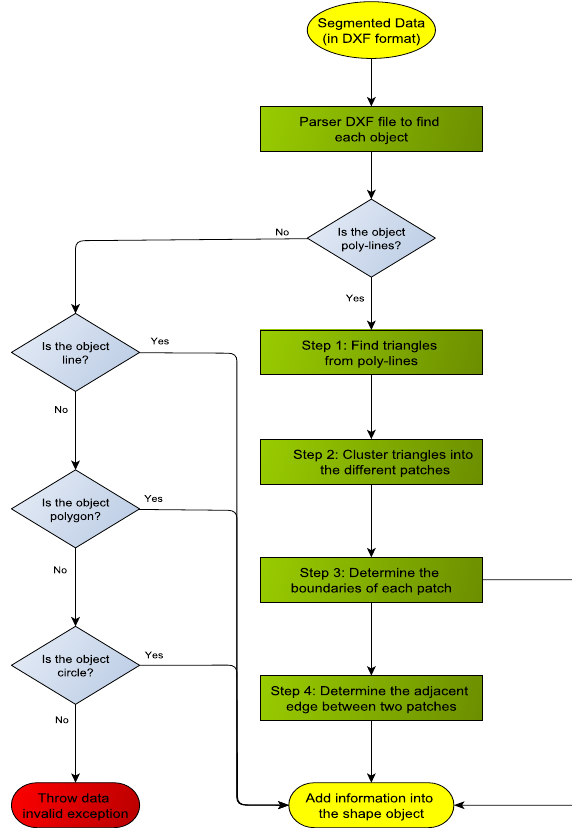
Figure 4: The main flow of the Segmentation-to-Shape